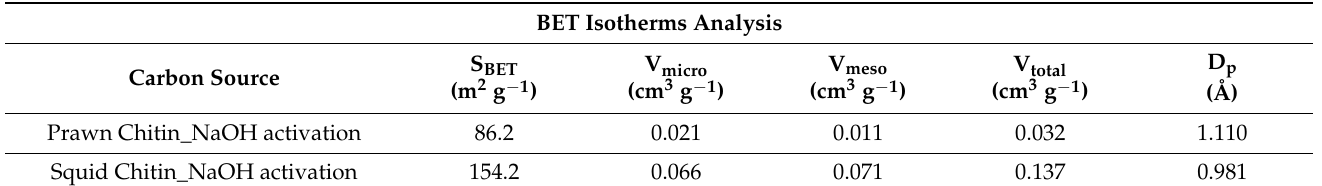
Table 6. BET surface area parameters of the chitin-based carbon materials with and without activation procedure.